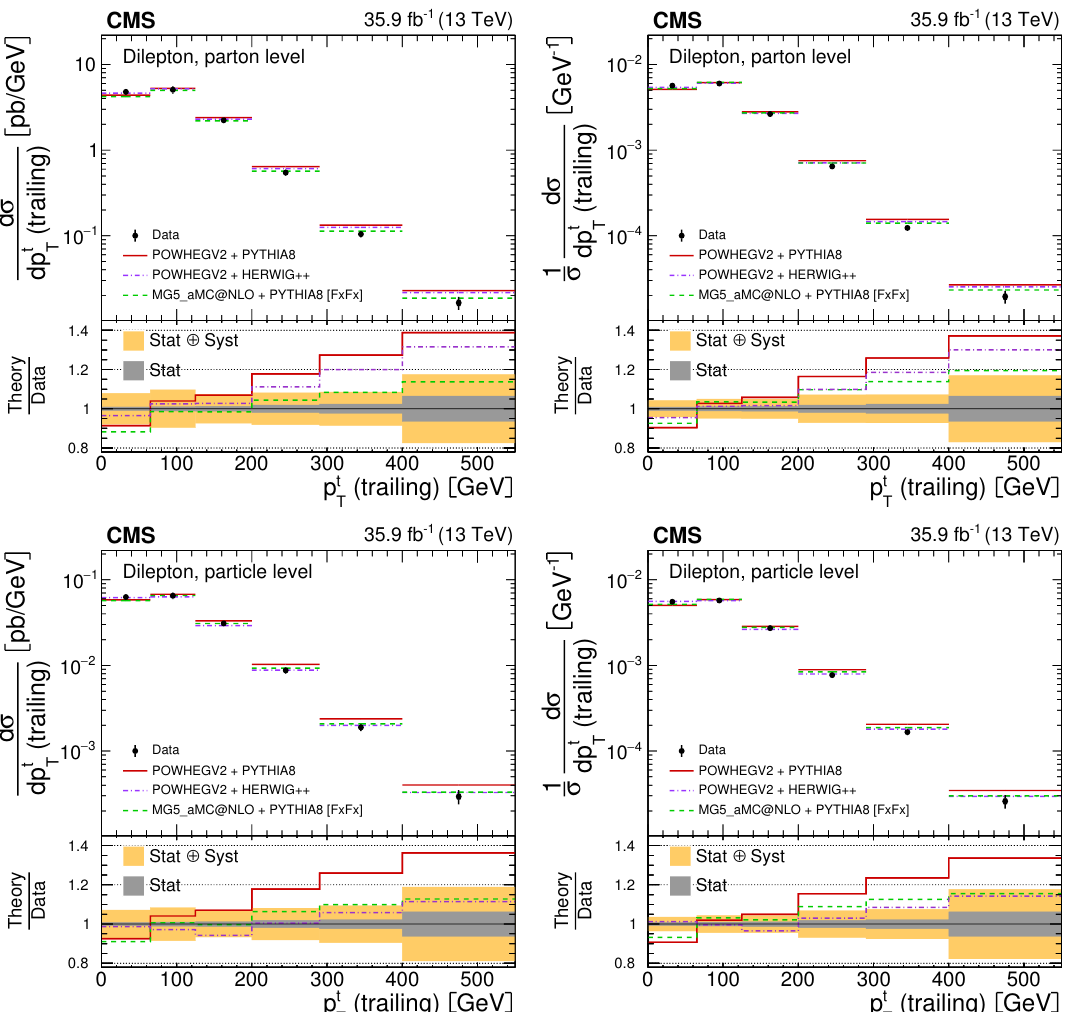
Figure 10 . The di(cid:11)erential tt production cross sections as a function of p t for the data (points) and the MC predictions (lines). The vertical lines on the points indicate the total uncertainty in the data. The left and right columns correspond to absolute and normalised measurements, respectively. The upper row corresponds to measurements at the parton level in the full phase space and the lower row to the particle level in a (cid:12)ducial phase space. The lower panel in each plot shows the ratios of the theoretical predictions to the data. The dark and light bands show the relative statistical and total uncertainties in the data, respectively.